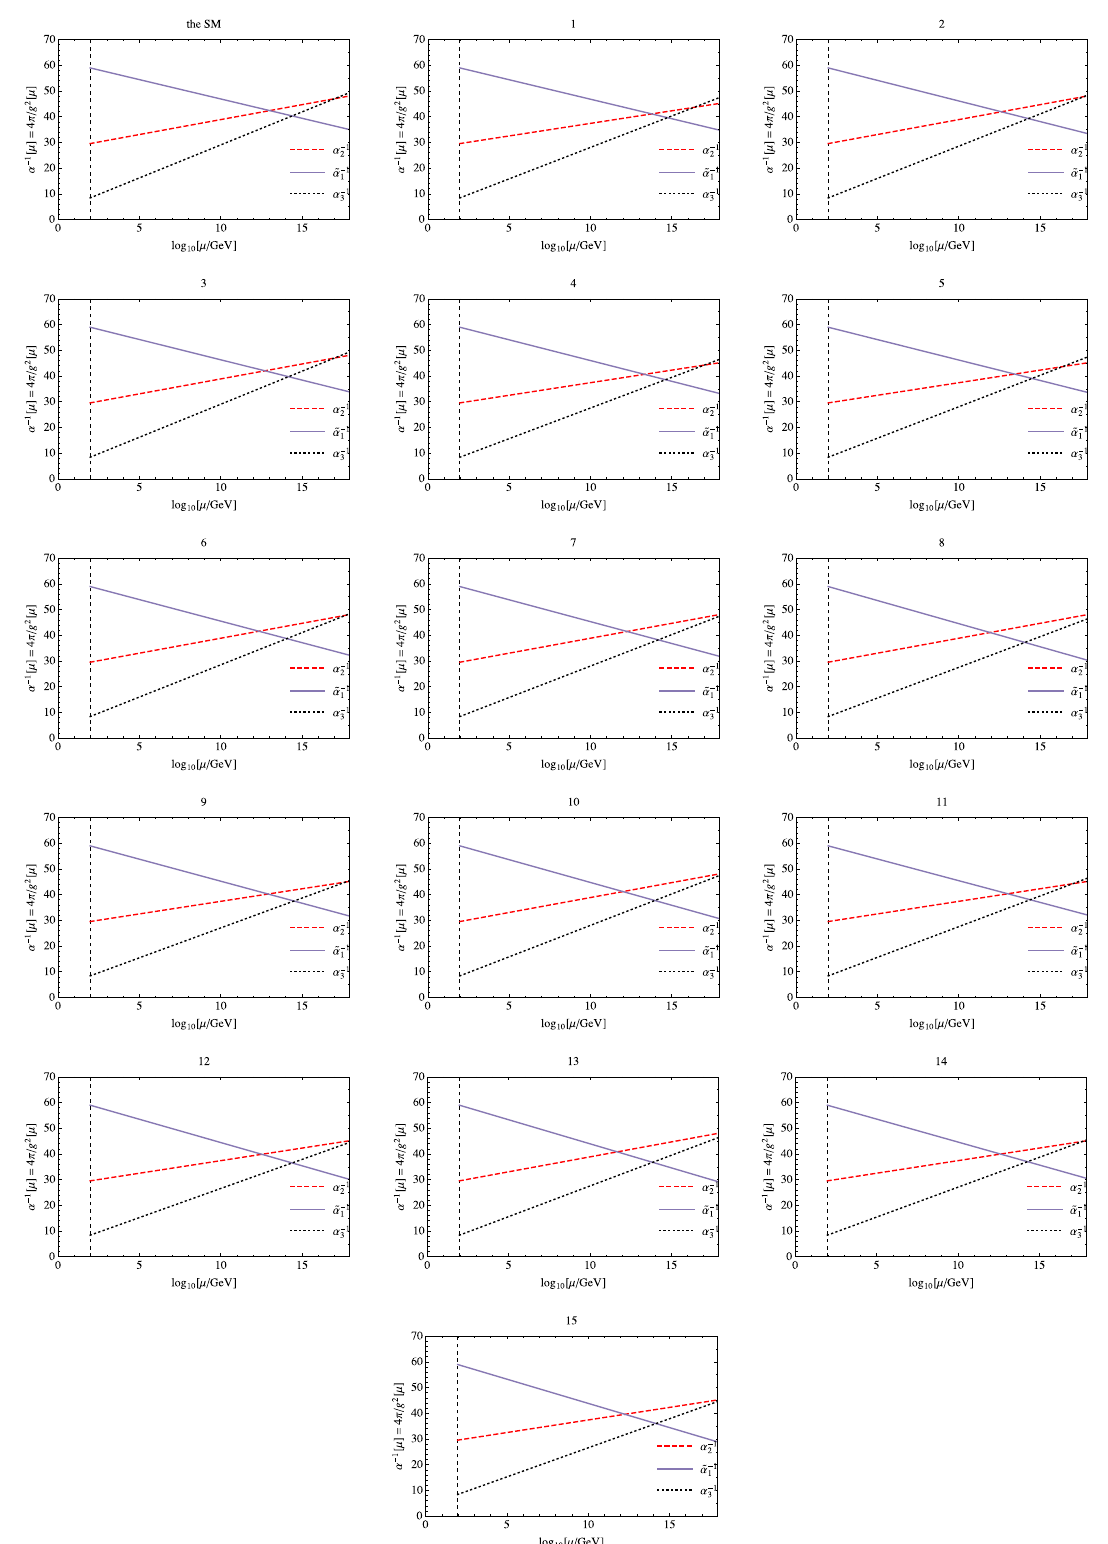
Fig. 1 Running of the gauge couplings for each scalar field configu- ration in the special case given in Table 1. The SM running is given in the first plot for comparison. The vertical dotted line correspond